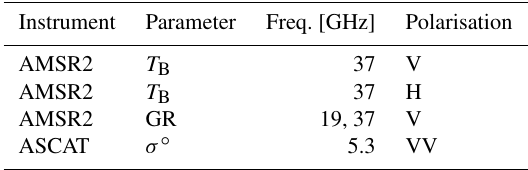
Table 1. Input parameters (“channels”) used in Antarctic sea ice type retrieval with ECICE. Note: T B is the brightness temperature, GR is the gradient ratio (see Eq. 2), and σ ◦ is the normalised radar backscattering cross section